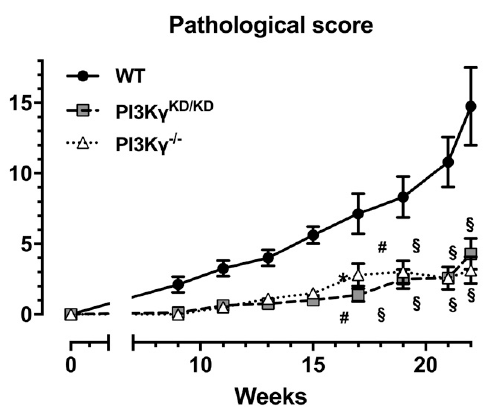
Figure 2. Mean pathological score (as the sum of the score of every single lesion per animal) of WT, PI3K γ KD/KD and PI3K γ –/– mice receiving 4NQO treatment are shown. PI3K γ KD/KD /PI3K γ –/– vs. WT: * PI3K γ KD/KD and PI3K γ − / − mice receiving 4NQO treatment are shown. PI3K γ KD/KD /PI3K γ − / − vs. p < 0.05, # p < 0.01 and § p < 0.001. WT: * p < 0.05, # p < 0.01 and § p <